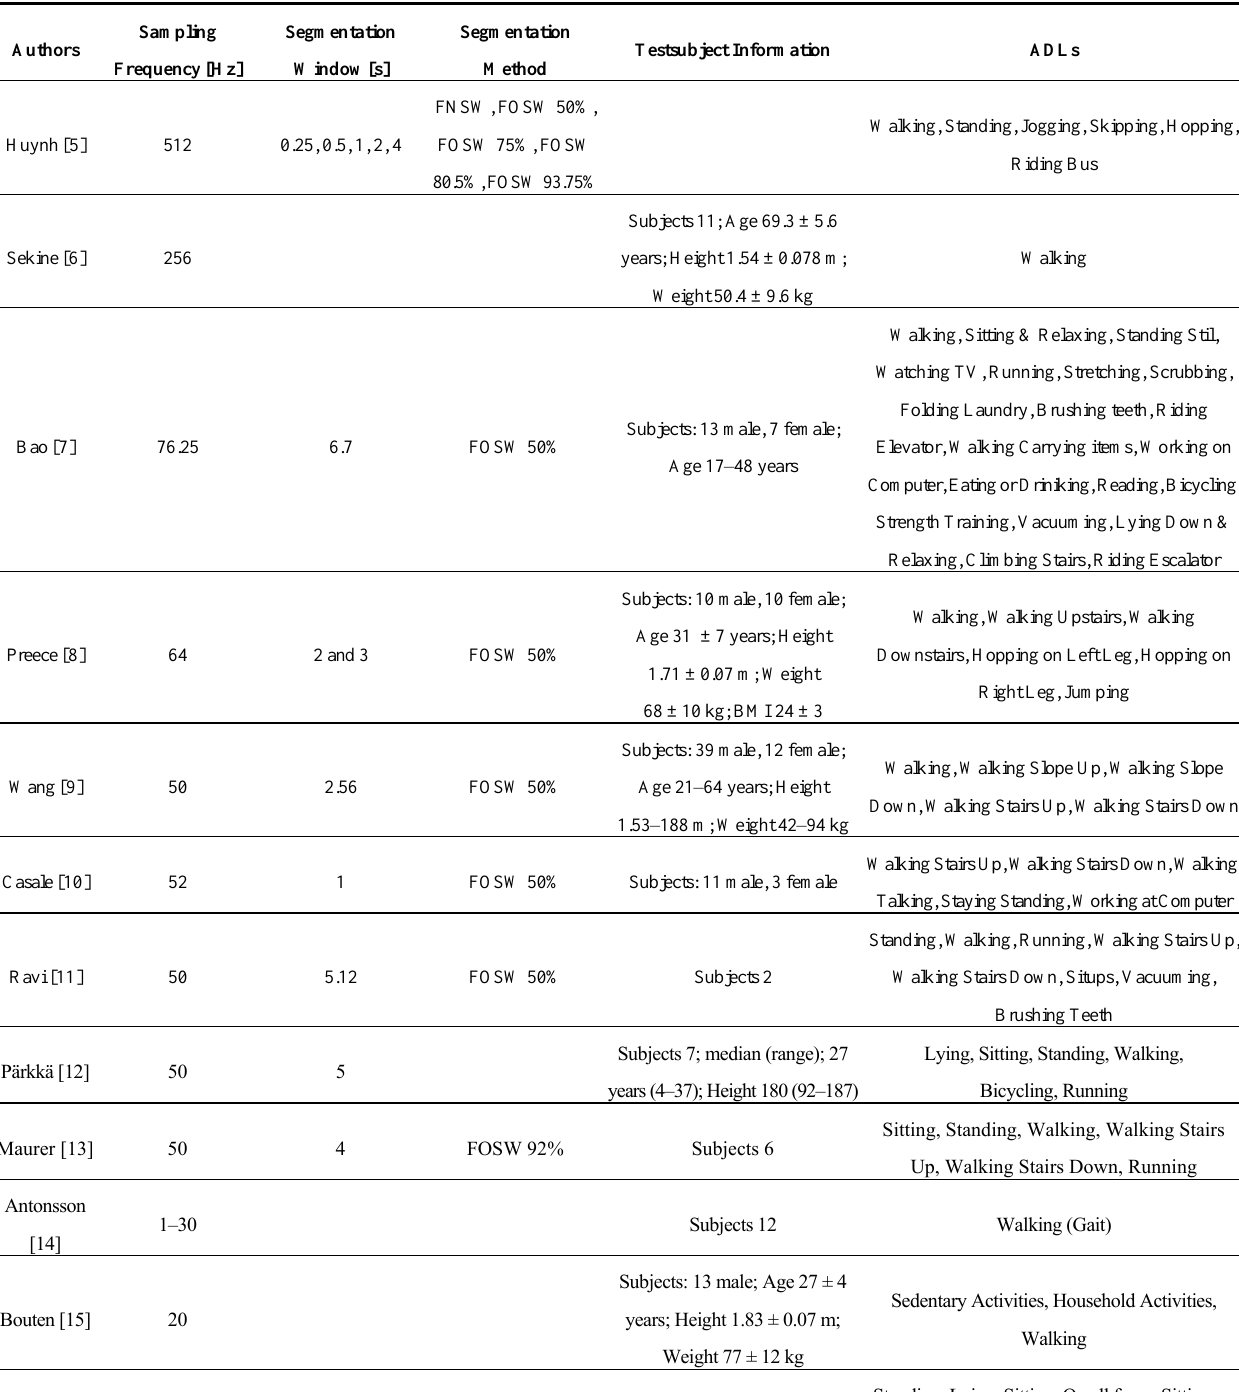
Table 1. Inconsistency in sampling rates and segmentation windows for